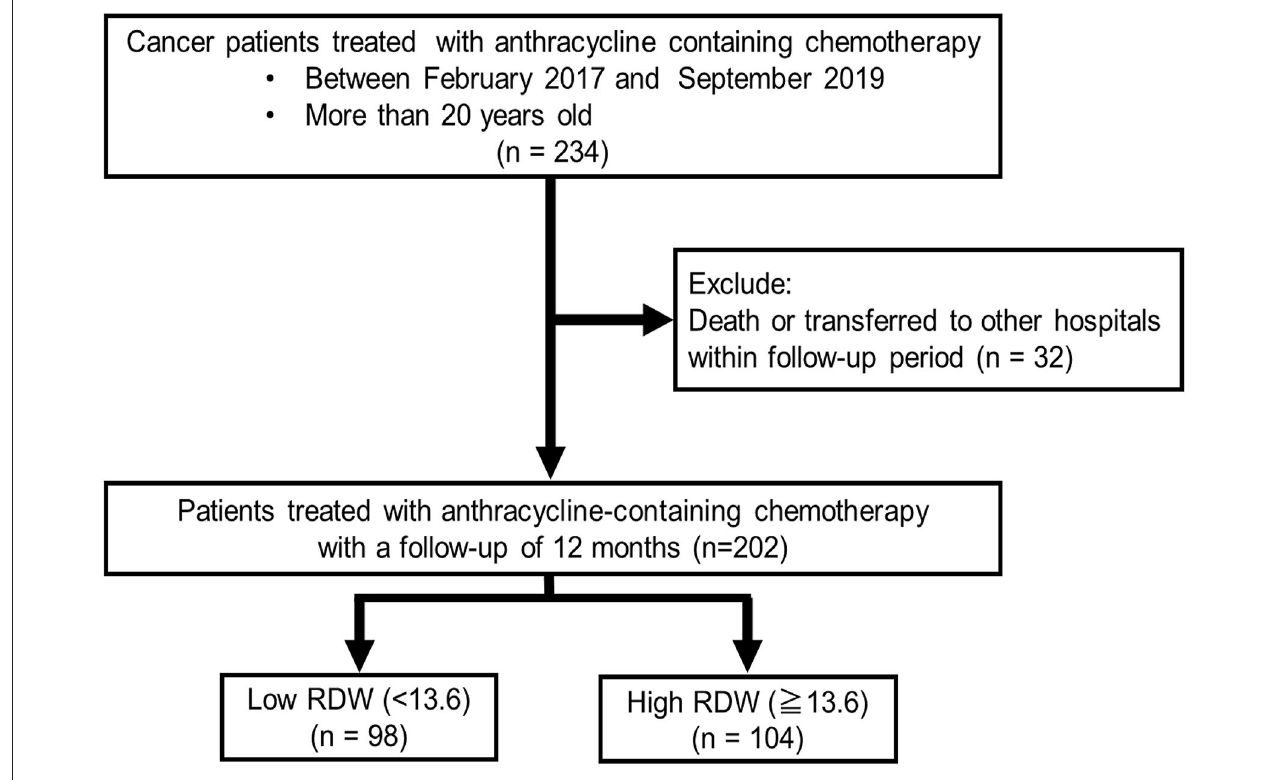
FIGURE 1 | Patient cohort